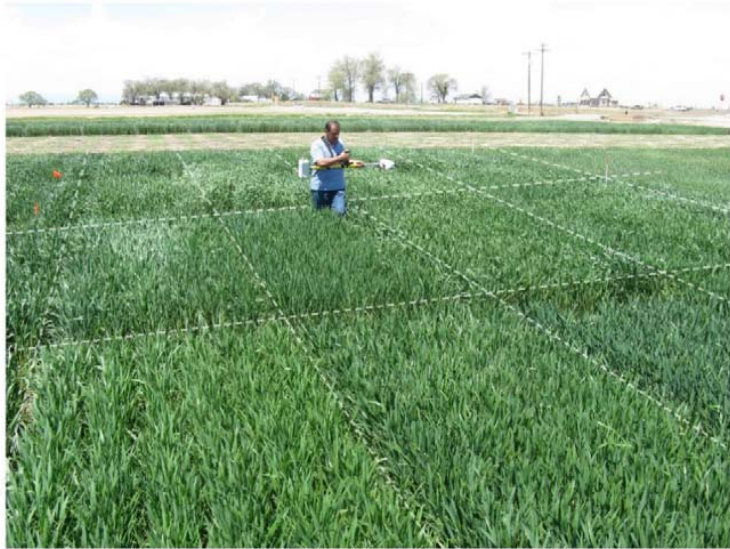
Figure 1. A GreenSeeker handheld optical sensor unit was used to collect NDVI measurements from crop canopy. Highlighted white dashed lines are delineated to differentiate the boundaries of each plot.